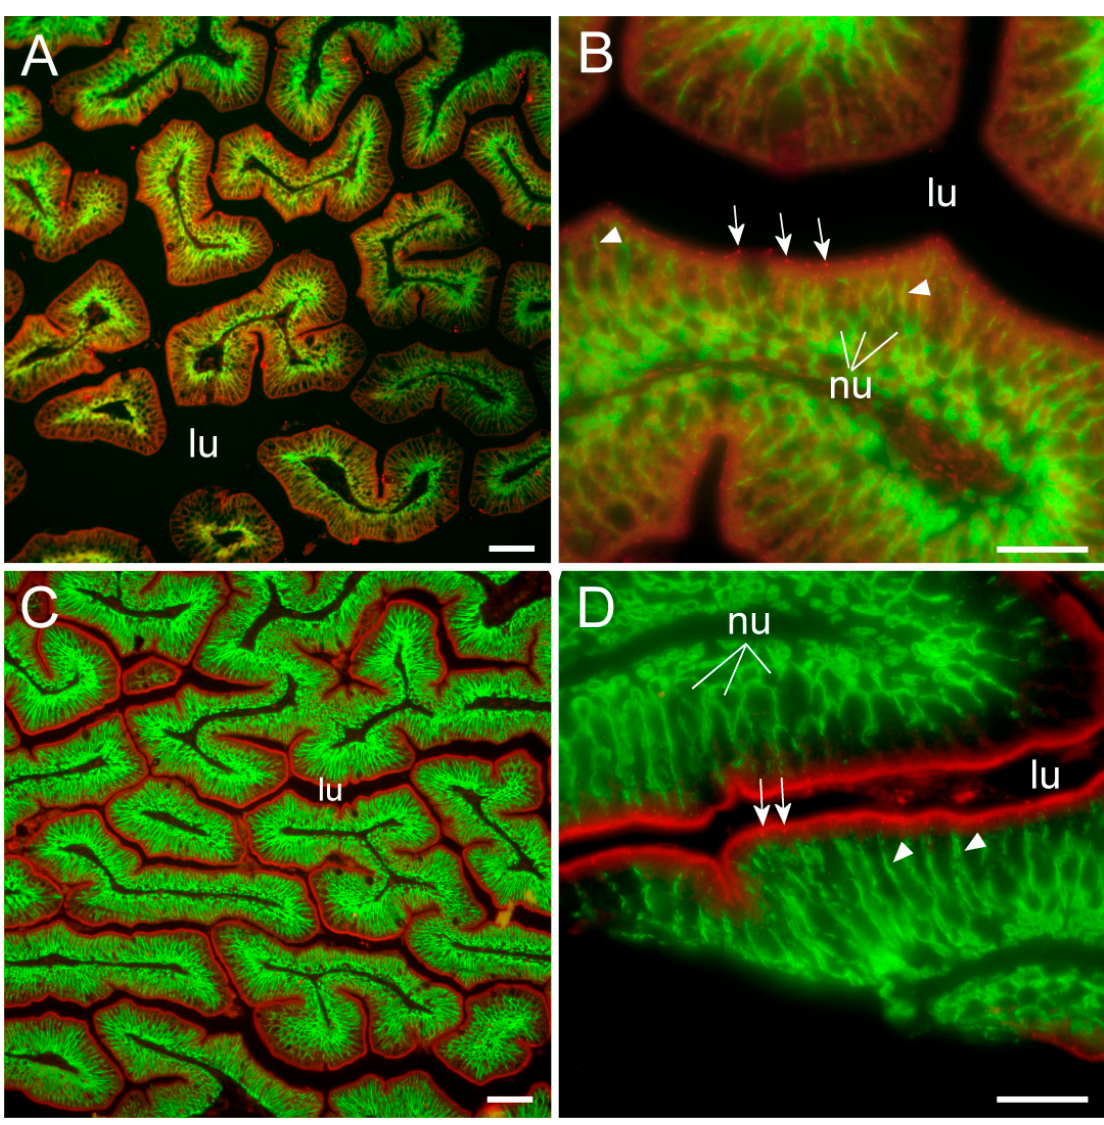
Figure 6. Immunofluorescence micrographs showing apical localization of Cldn15a (red, in A and B ), and Cldn15b (red in C and D ) and basolateral localization of the Na + ,K + -ATPase alpha subunit (green) in FW-acclimated medaka middle intestine. ( A ) and ( C ) are at 200× magnification, ( B ) and ( D ) are at 1000× magnification. lu = lumen, nu = nuclei; in ( B ) and ( C ) arrows point to Cldn “hot spots” in the tight junction zones; arrowheads point to lateral membranes. Size bars indicate 50 μ m ( A , C ) or 20 μ m ( B , D ).